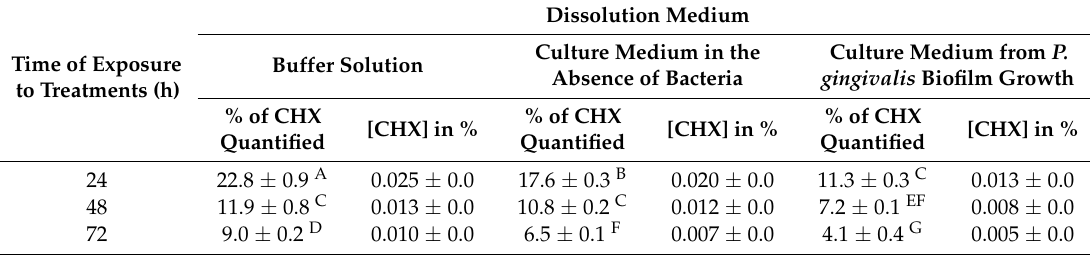
Table 3. Percentage of chlorhexidine (CHX) quantified and the final CHX concentration (in percentage) in the buffer, culture medium in the absence of bacteria and the culture medium from P. gingivalis biofilm growth at 24, 48 and 72